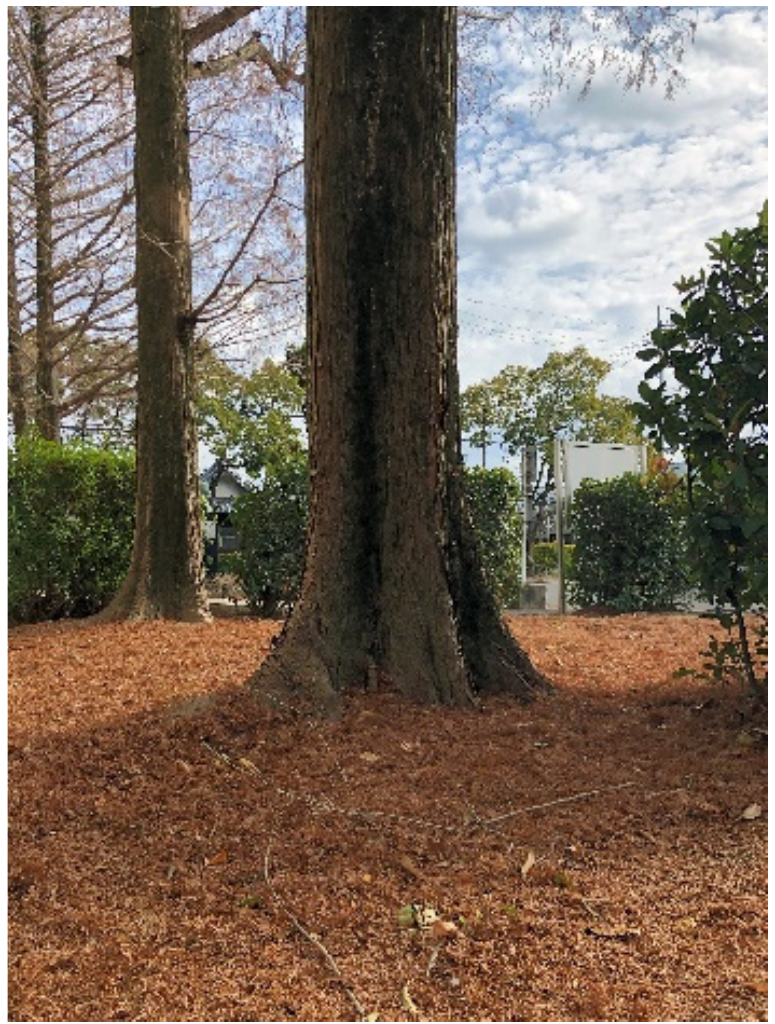
Figure 1. Fallen M. glyptostroboides leaves accumulated on the soil.